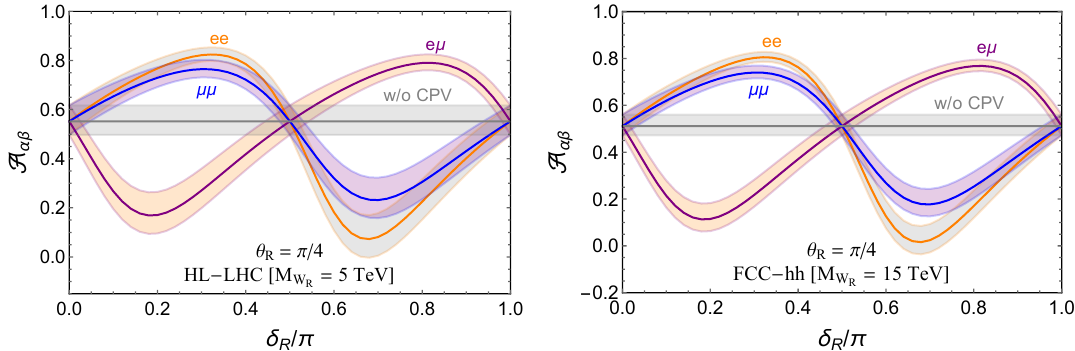
Figure 3. Prospects of charge asymmetry future 100 TeV collider FCC-hh (right) with M W (cid:18) R = (cid:25)= 4. The (cid:13)avor combinations ee , (cid:22)(cid:22) and e(cid:22) are depicted respectively in orange, blue and purple, and the horizontal gray bands correspond to the case without CPV. The solid lines denote the central values and the shaded bands are due to the PDF